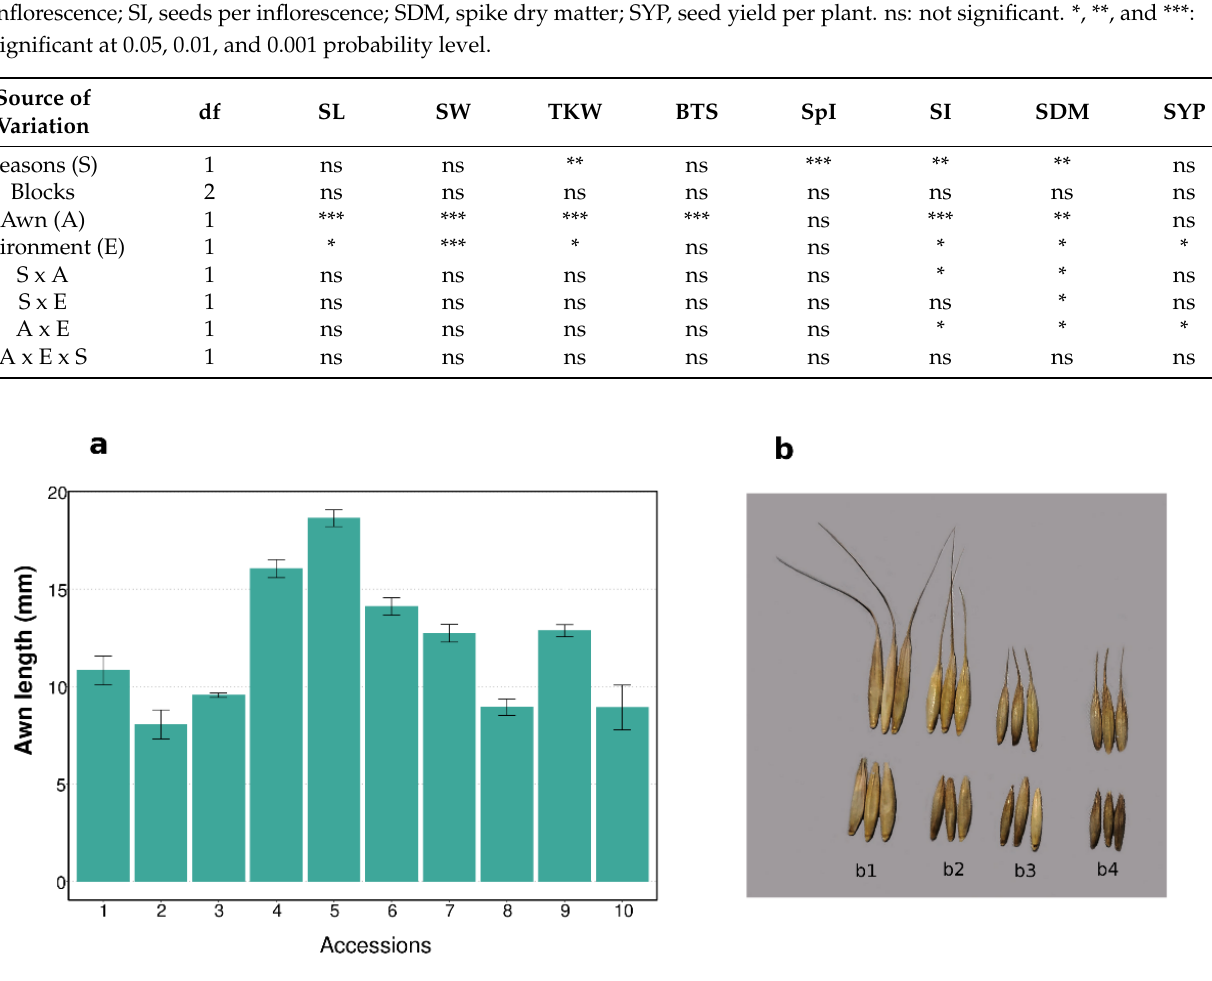
Figure 2. Characterization of Siberian wildrye accessions used in the study. ( a ) Awn length of 10 accessions used in the study. ( b ) Seeds of ZN03 and TZ02 accessions. b1 and b2 are awned and de-awned seeds of ZN03 under rainfed and irrigated conditions, respectively. b3 and b4 are awned and de-awned seeds of LT02 grown under rainfed and irrigated conditions, respectively. Each bar represents the mean value ± standard deviation.